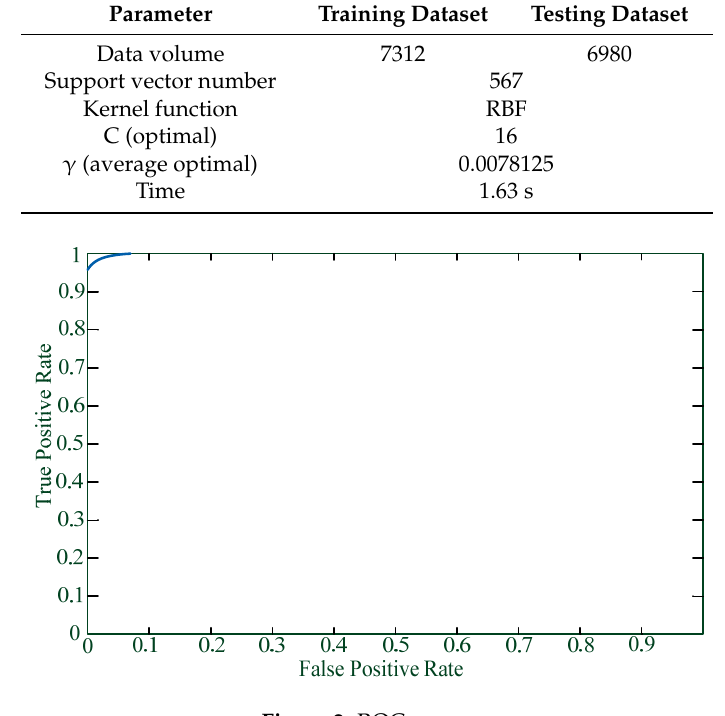
Figure 2. ROC curve.